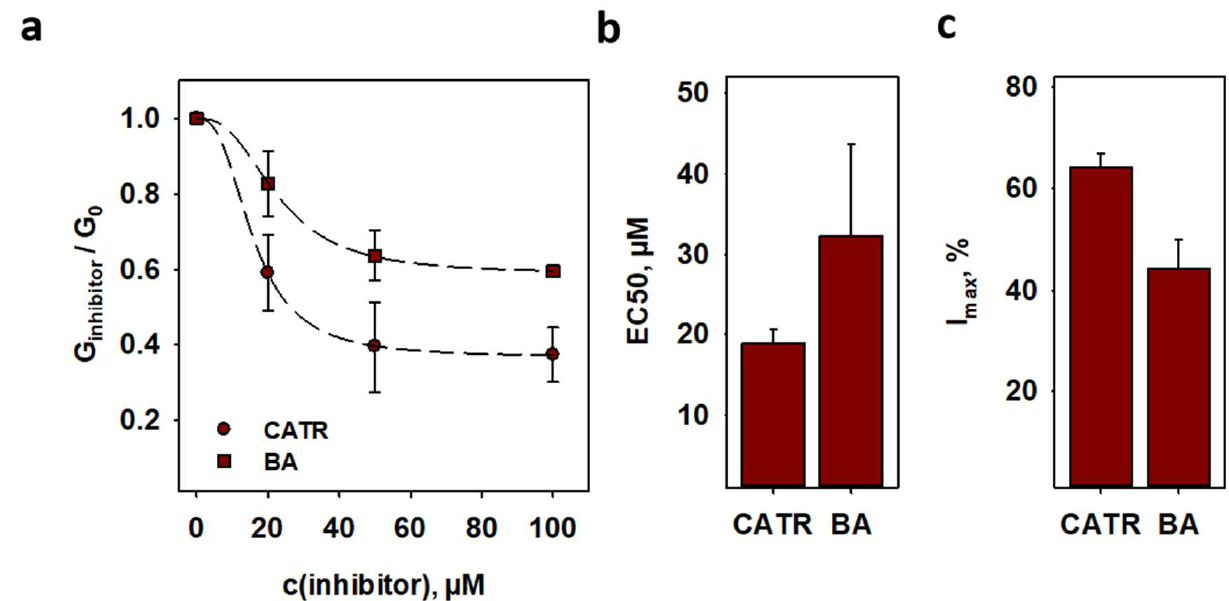
Figure 4. The ADP/ATP exchange inhibitors inhibit ANT-mediated proton leak. ( a ) Dose-dependent inhibition of ANT- mediated proton leak by the inhibitors CATR (circles) and bongkrekic acid (BA, triangles) on proton leak (dark red). Lines are a least square regression fit of a sigmoidal function to the data. ( b ) EC50 and ( c ) maximum inhibition I max as fit parameters of ( a ). Planar bilayer membranes were made of 45:45:10 mol % PC:PE:CL reconstituted with 15 mol % AA. Buffer contained 50 mM Na 2 SO 4 , 10 mM Tris, 10 mM MES and 0.6 mM EGTA at pH = 7.34 and T = 306 K. Lipid concentration was 1.5 mg/(mL of buffer solution). Protein concentration measured by BCA assay was 4 µ g/(mg of lipid). Data are the mean ± SD of at least three independent experiments.